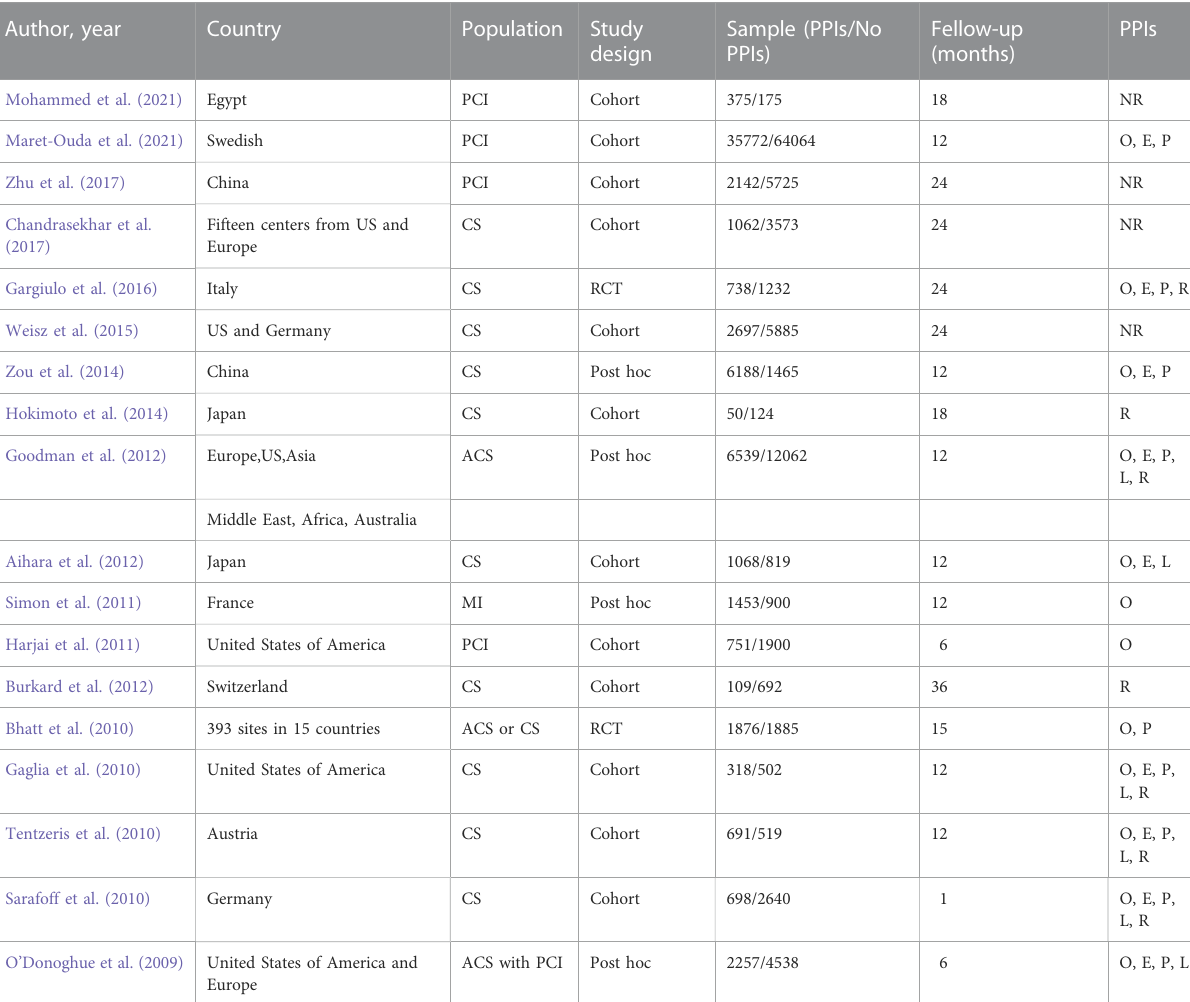
TABLE 1 Main characteristics of included